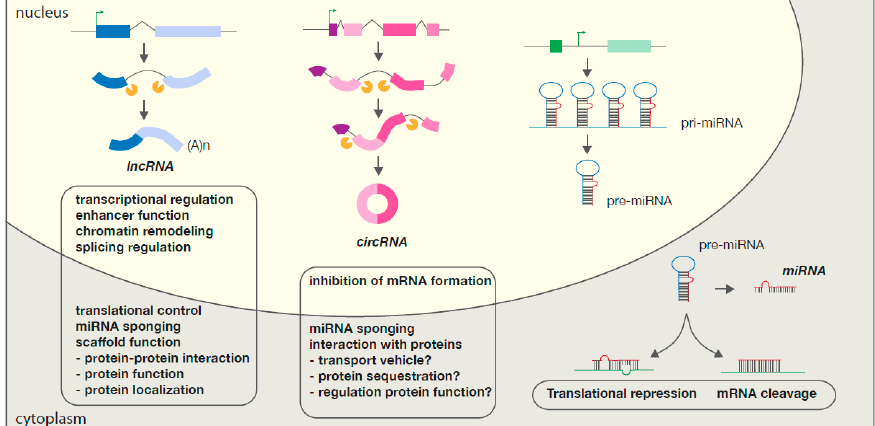
Figure 3. Di ff erent ncRNA species: their transcription from the eukaryotic genome and respective functions. Exons in protein-coding genes can be transcribed into lncRNAs (blue) and circRNAs (purple), normally after intron exclusion by the spliceosome (orange). miRNAs (green), in turn, can derive from intronic sequences or intergenic regions. LncRNAs are a large class of transcribed RNA molecules with a length of more than 200 nucleotides that are mostly located exclusively in the nucleus. They are often transcribed as whole or partial antisense transcripts to coding genes and can structurally resemble mRNAs. They exert their function by binding DNA, RNA, or proteins, to regulate gene expression at multiple levels via base pairing or secondary structure formation, respectively. LncRNAs, by acting as either signals, decoys, guides, and / or sca ff olds, can recruit epigenetic factors to change patterns of chromatin organization, activate or repress the gene transcription by interacting with specific regulatory regions or transcription factors and manipulate mRNA function by regulating alternative